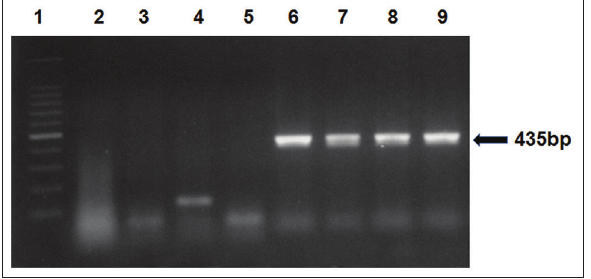
Figure-1: Detection of enterovirus (EV) RNA by reverse- transcriptase PCR using primers ENV-F and ENV-R1. Lane 1: 100 bp DNA ladder, Lane 2: Negative control, Lanes 3-5: EV-negative samples, Lane 6: Meretrix meretrix , Lane 7: Perna viridis , Lane 8: Villorita cyprinoides , Lane 9: Positive control.